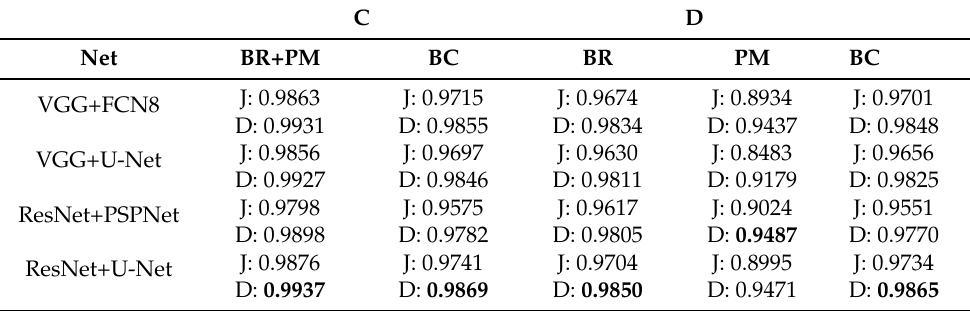
Table 8. Segmentation metrics for experiments C and D. Best results in bold.